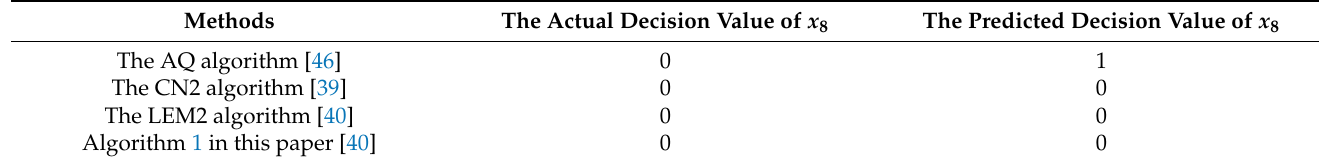
Table 9. The decision results of x 8 utilizing different methods for Example 8.